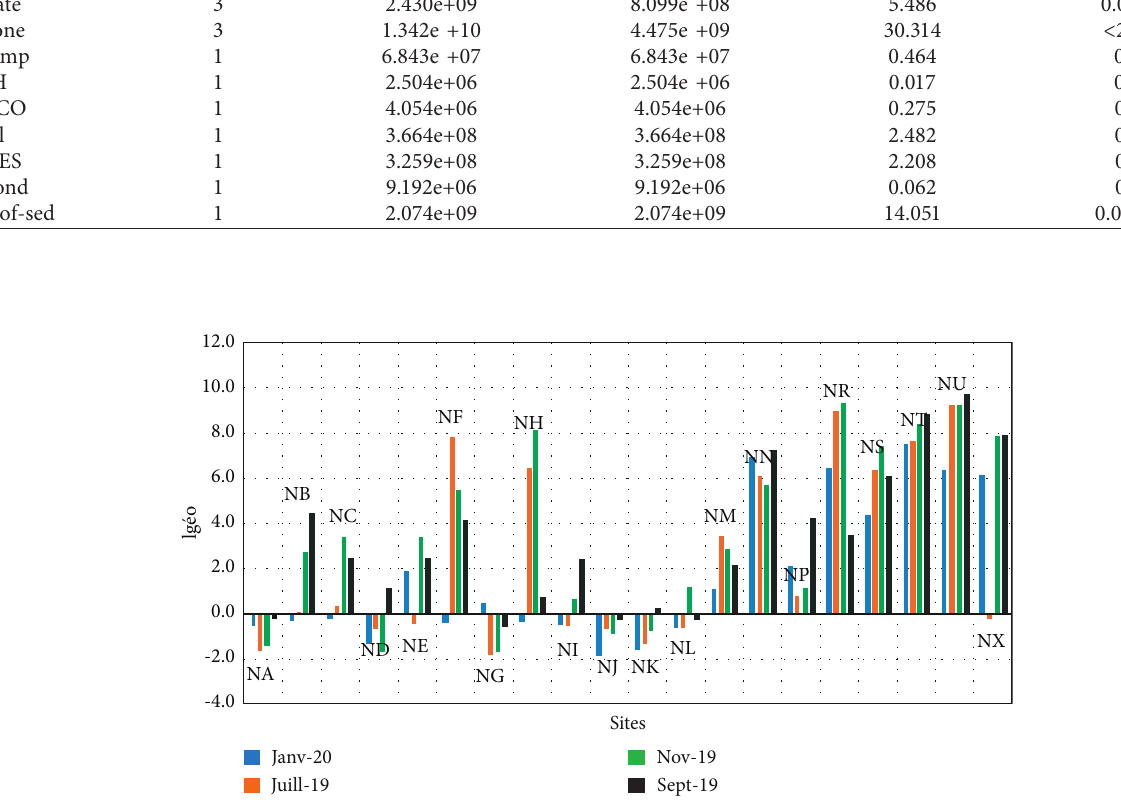
Figure 9: Averages of Igeo values of the sediments with respect to the